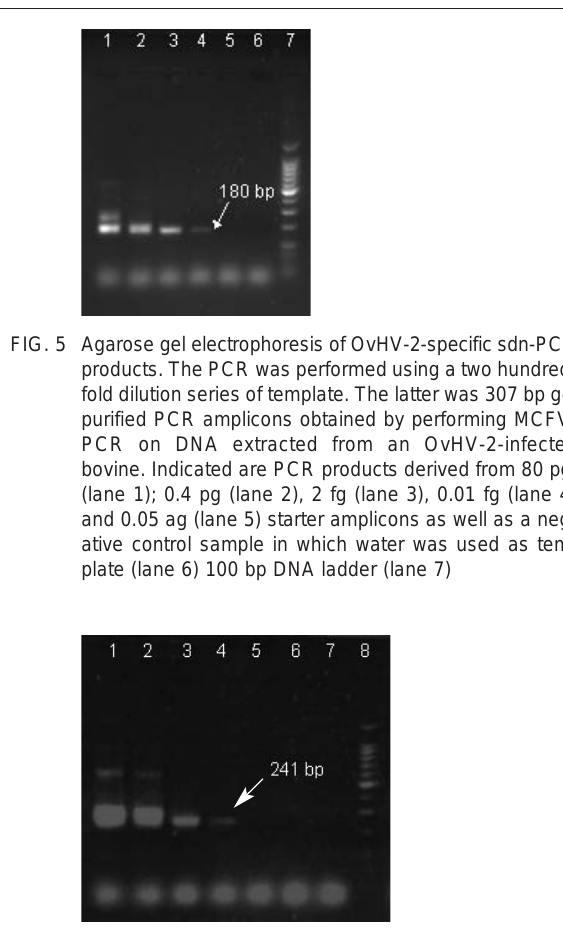
FIG. 3 An agarose gel showing electrophoretic separation of sdn-PCR products of DNA extracted from different field samples from the blood of bovines infected with OvHV-2 (lanes 1–4) or AlHV-1 (lanes 7–10), respectively. Lane 5 contains a sample of the PCR product from DNA extract- ed from the blood of an uninfected bovine and lane 6 contains a 100 bp DNA ladder